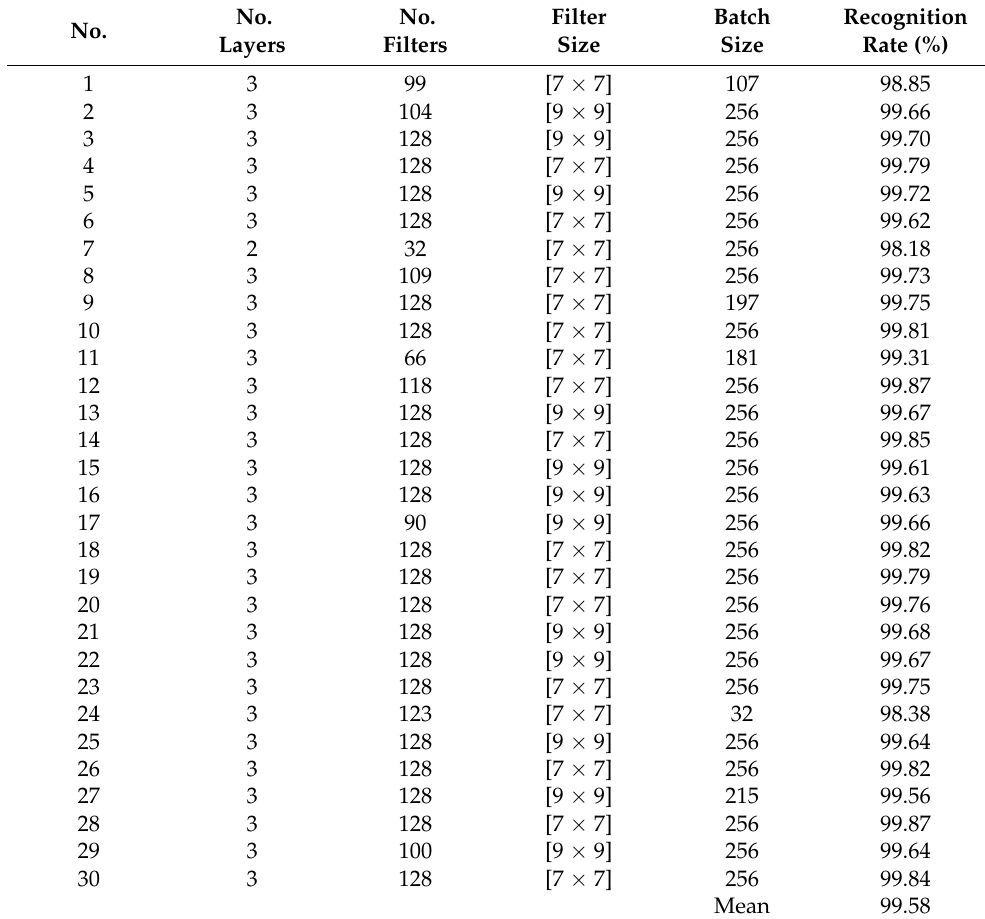
Table 9. Results achieved by the PSO-CNN-I in ASL alphabet database.